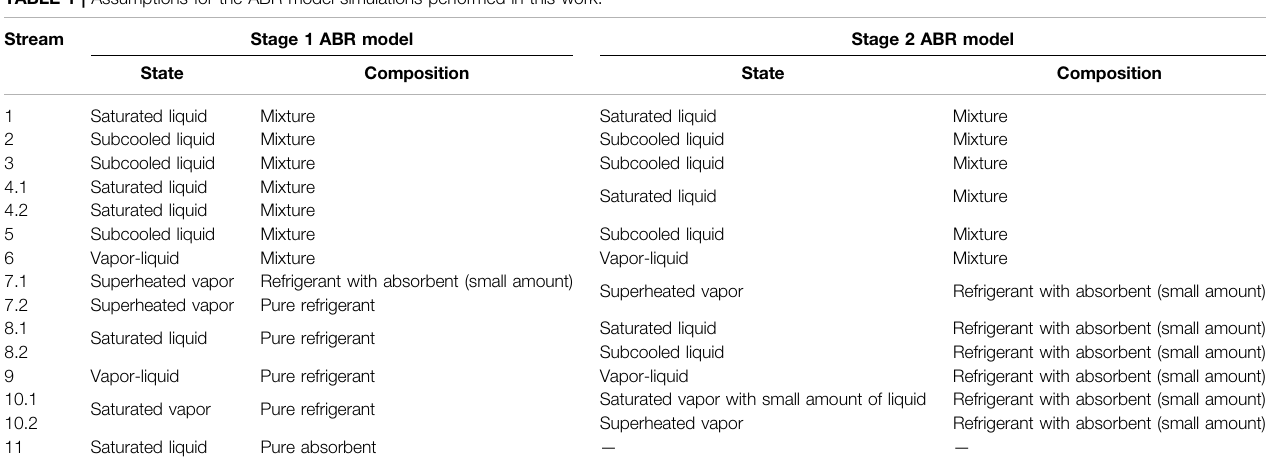
TABLE 1 | Assumptions for the ABR model simulations performed in this